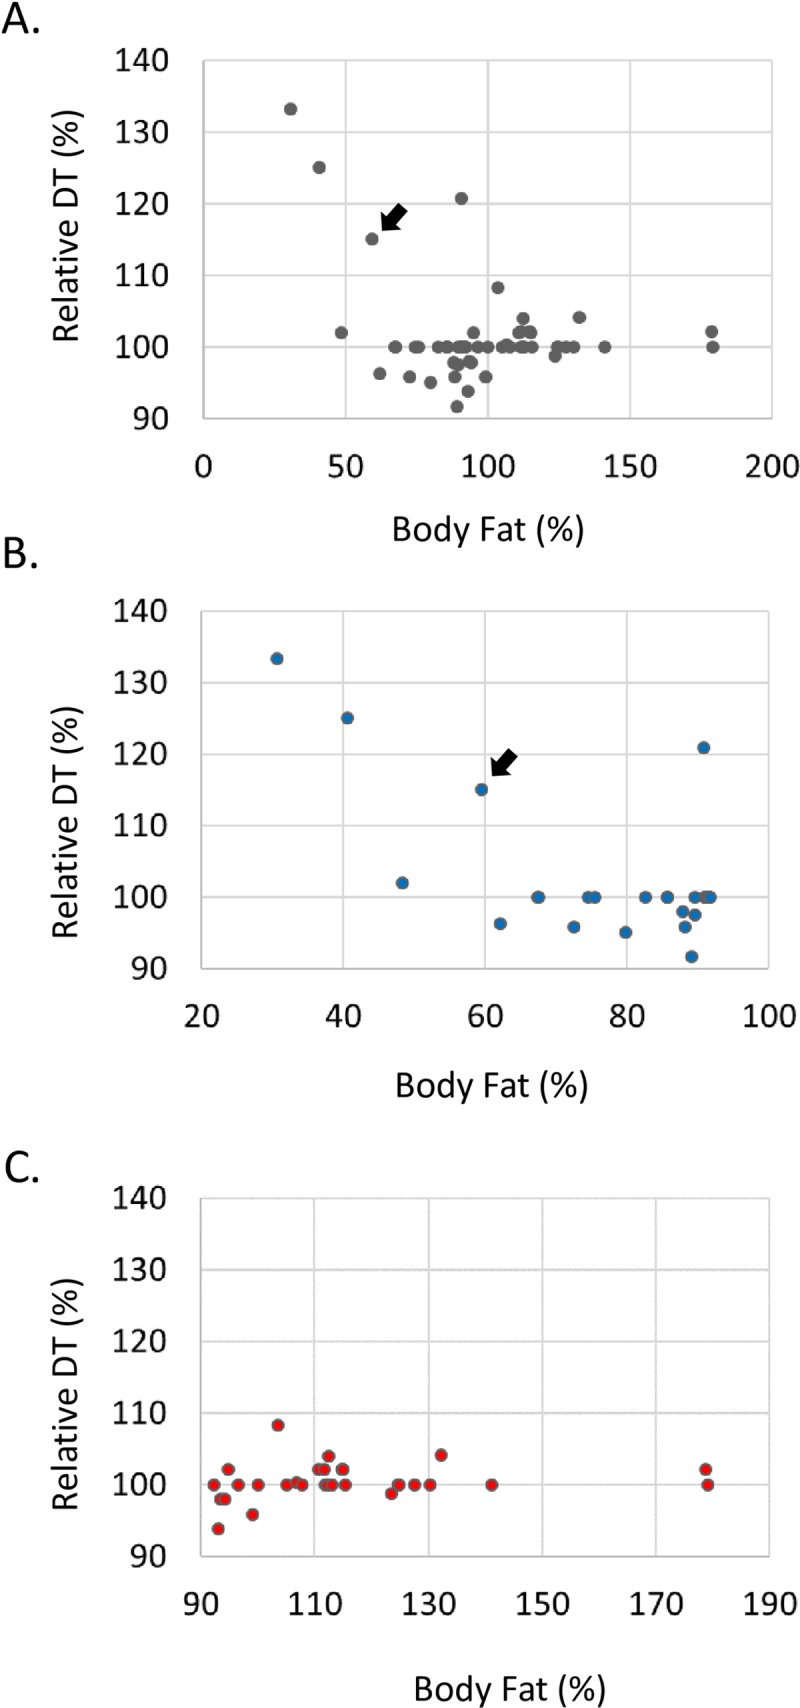
Negative correlation between the body fat content and developmental time.(A) Randomly-chosen 58 miRNA lines were used to plot egg-to-adult developmental time (DT) against male body fat content. Each coordinate represents the fat content and DT of a miRNA line. The linear correlation test in SPSS was used for a statistical test. Pearson correlation coefficient (r) was -0.330, and probability (P) value was 0.011. Relative DTs were calculated using the following formula: Relative DT (%) = (DTmiRNA/DTcontrol) X 100. Controls were generated by crossing W1118 to the same Act5C-Gal4 driver. The black arrow shows miR-969. (B) Only the 28 miRNA lines with low body fat were considered in this analysis. Pearson correlation coefficient (r) was -0.744, and P value was lower than 0.011. The black arrow shows miR-969. (C) The other 33 miRNA lines with high body fat were analyzed. Pearson correlation coefficient (r) was 0.206, and P value was 0.249.